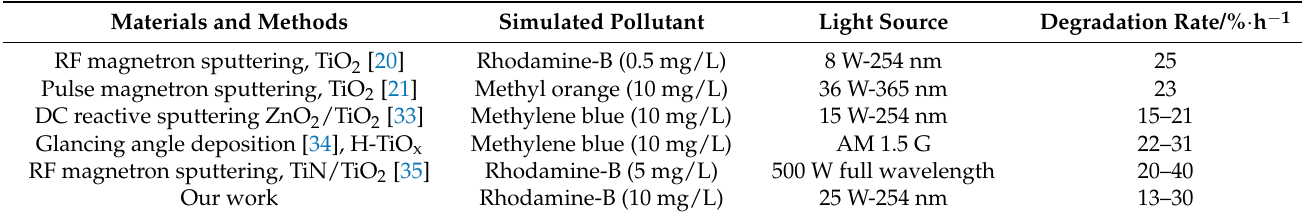
Table 4. The photocatalytic efficiency of some TiO 2 films by sputtering